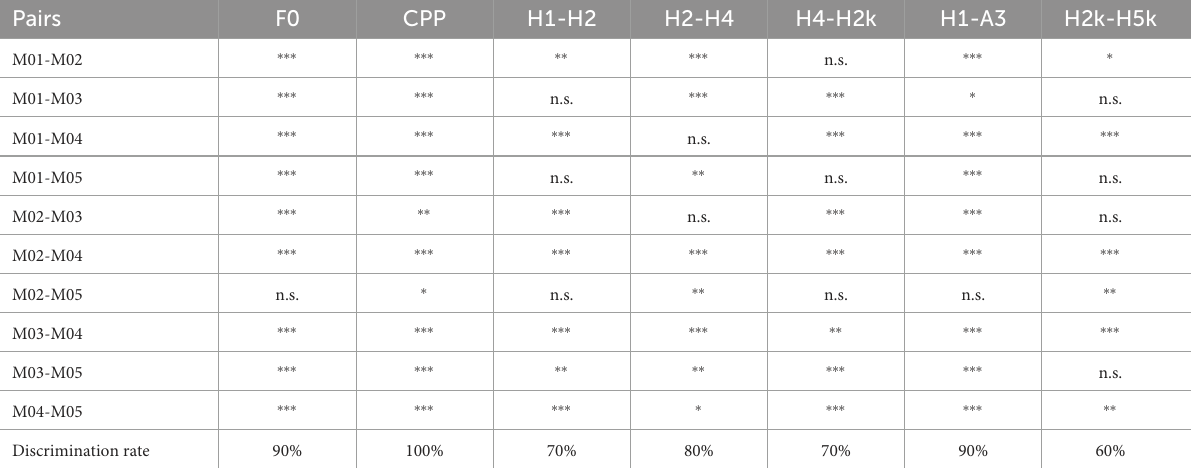
TABLE 5 Results of statistical